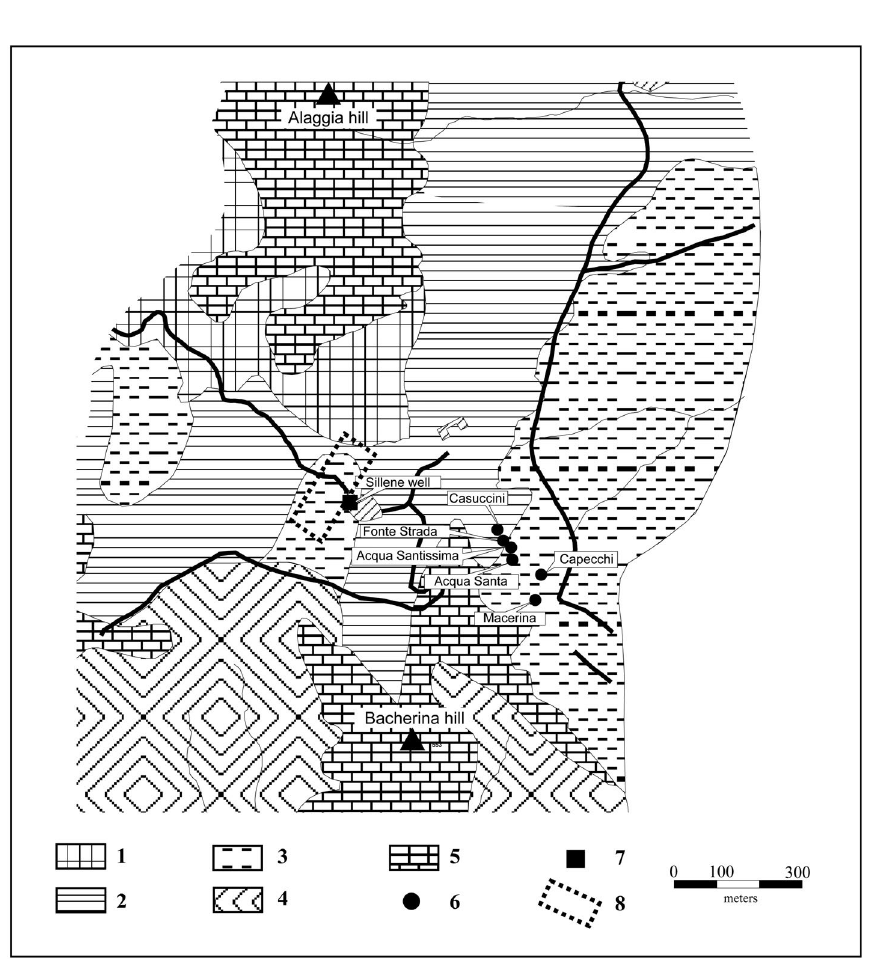
Fig. 2. Schematic geological map of the Chianciano thermal basin (after Compagnia Mediterranea di Prospezioni, 1973, modified). 1 = Recent alluvium; 2 = sands and clayey sands; 3 = clays and silty clays; 4 = clayey turbidites; 5 = limestones and dolomites; 6 = thermal springs; 7 = Sillene well; 8 = survey